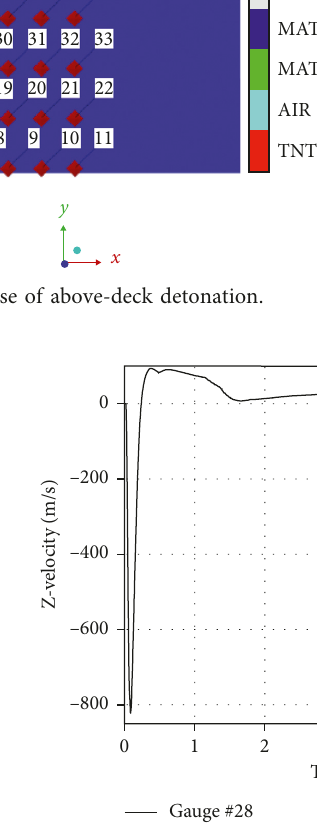
Figure 6: Pressure history of Gauge #28. Figure 7: Velocity history of Gauge